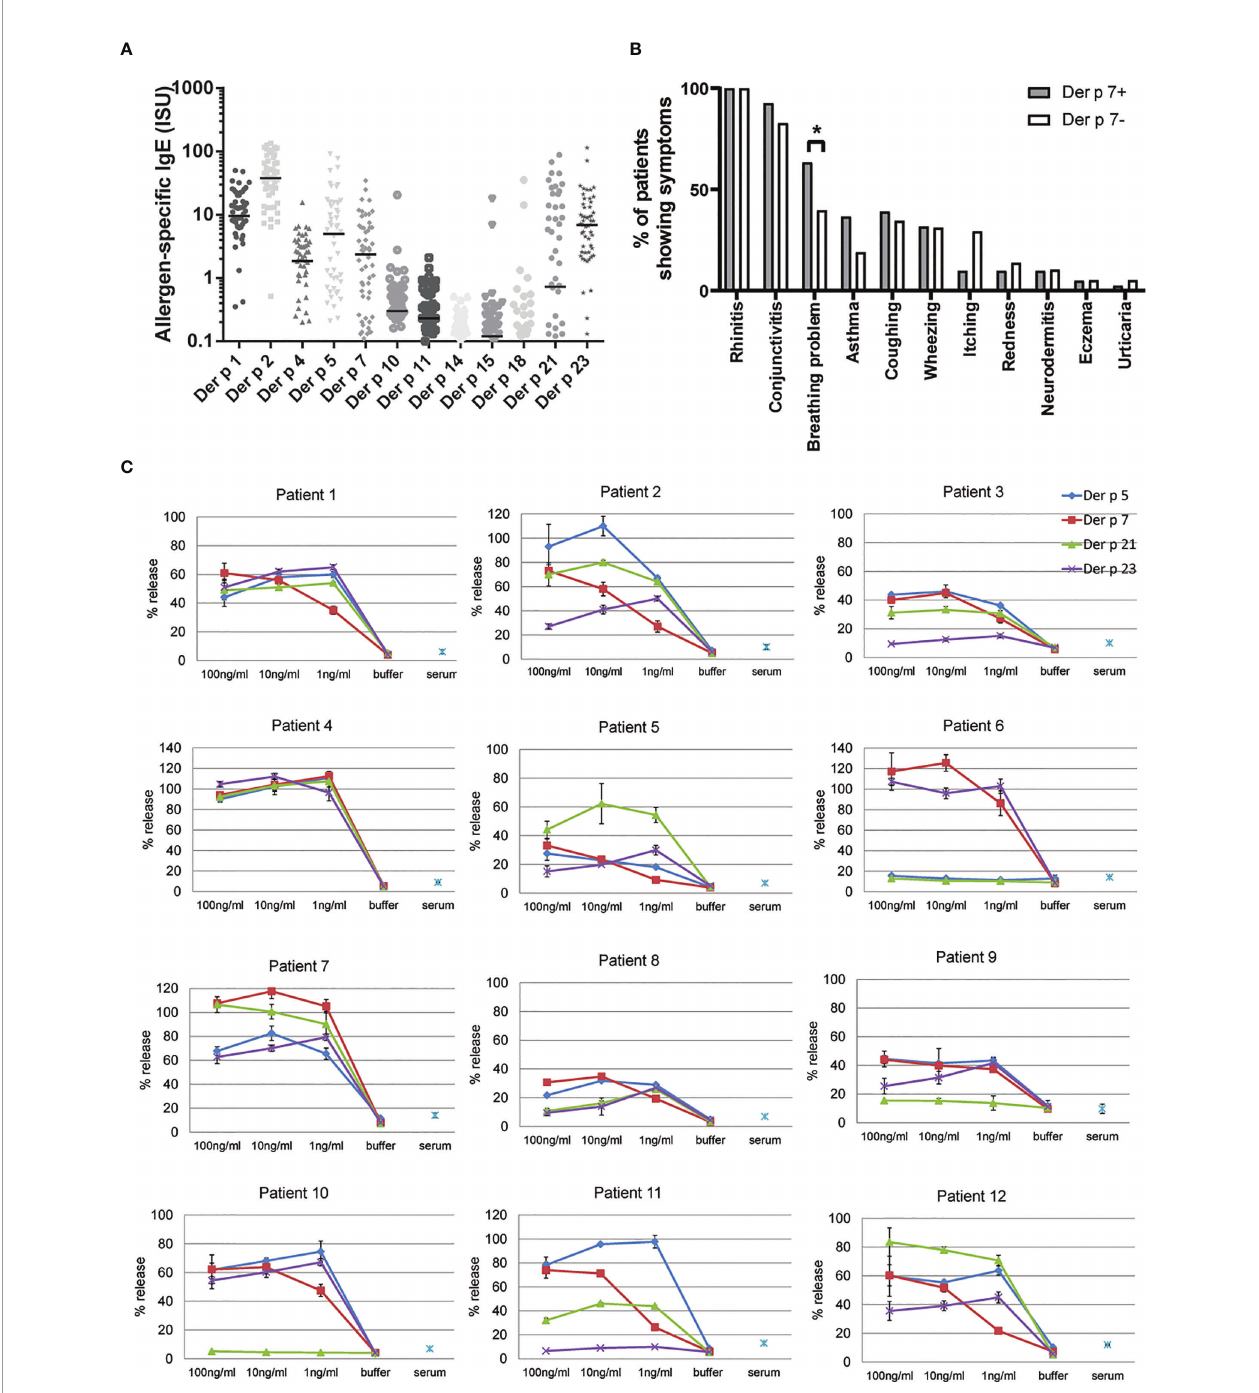
FIGURE 1 | Allergenic activity and possible clinical relevance of Der p 7 (A) IgE levels to individual HDM allergens. Speci fi c IgE levels (ISU, y-axis) to HDM allergens (x-axis) determined for patients with clinically con fi rmed HDM allergy (n = 100) are displayed as scatter plots and represent the means. Median values are depicted as horizontal lines. (B) Frequency of allergic symptoms in HDM allergic patients with or without sensitization to Der p 7. Statistically signi fi cant differences between the groups are indicated. *P < 0.05. (C) . Allergenic activity of Der p 7 in comparison with Der p 5, Der p 21, and Der p 23 as determined by basophil activation testing. RBL cells transfected with human Fc ϵ RI were loaded with sera from house dust mite-allergic patients (1 – 12) and were then exposed to decreasing concentrations (100, 10, and 1 ng/ml) of Der p 7, Der p 5, Der p 21, and Der p 23. Cells incubated with buffer and allergens (buffer) or with serum without allergens (serum) were used as negative controls. b -hexosaminidase releases are displayed as percentages of total b -hexosaminidase on the y-axes and represent the means of triplicates ±